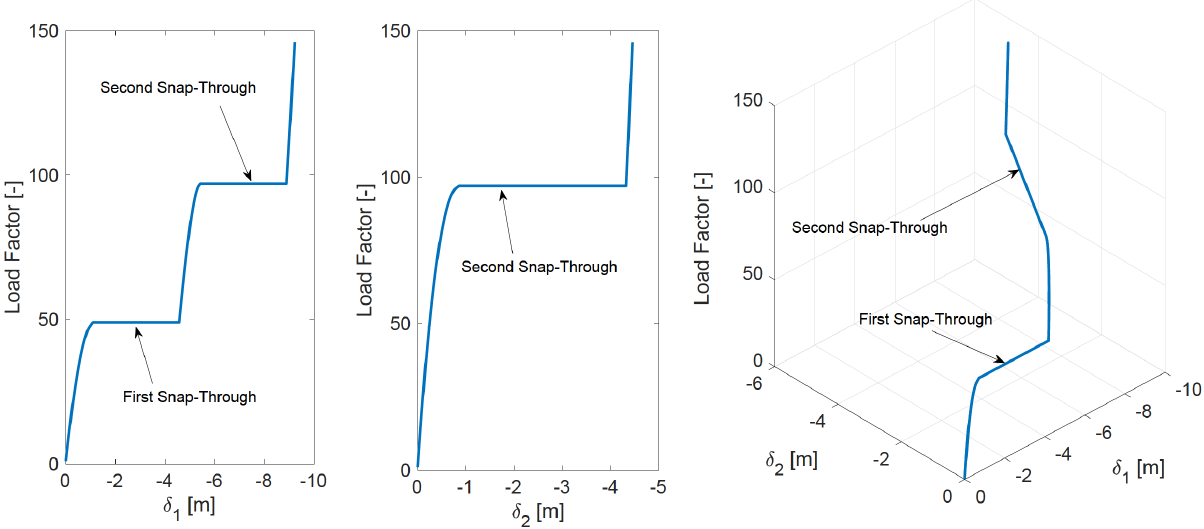
Figure 16: Sixteen-member structure load-displacement curves for increasing load (Case 1)